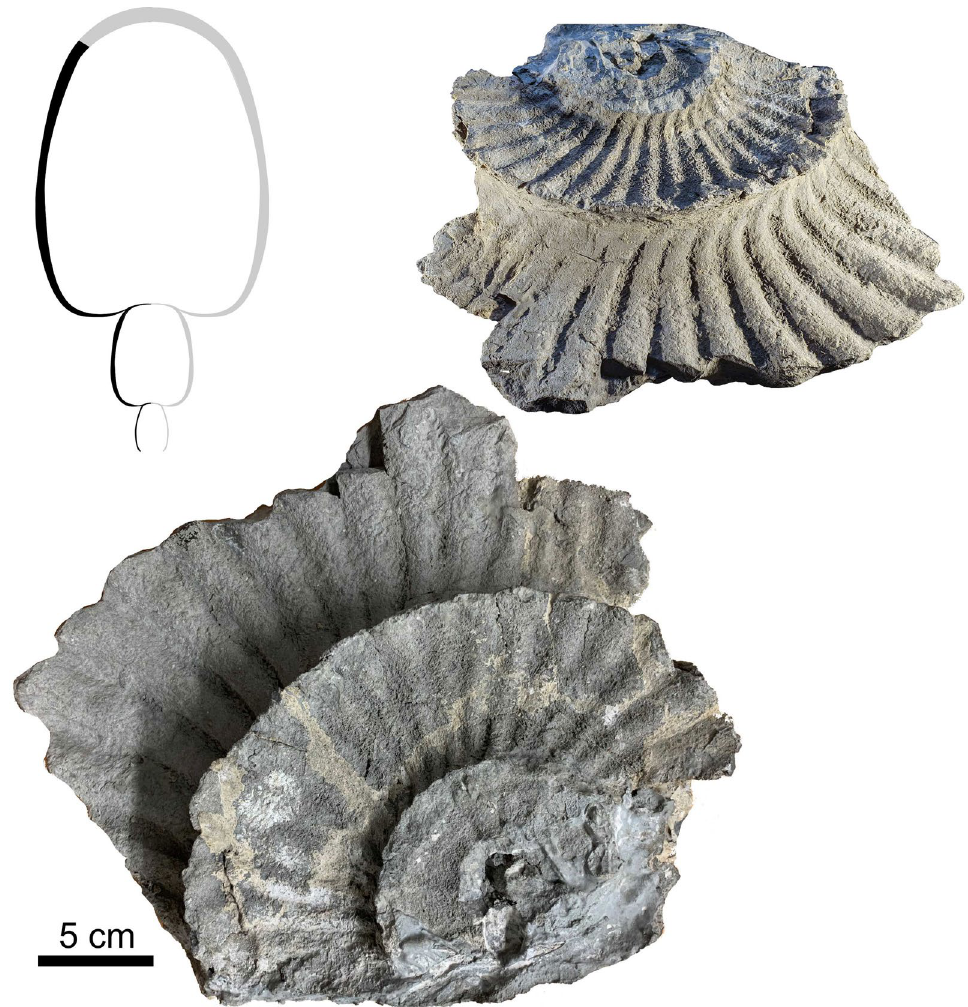
Fig. 17 Martelites sp., foundation works of the Hotel Metropol at Brunnen in the 60 s, Eidgenössische Technische Hochschule Zürich, cat. no. eth27789, “upper” Schrattenkalk. Umbillical and oblique view of the imprint and cross section (in black) with extrapolated parts in grey